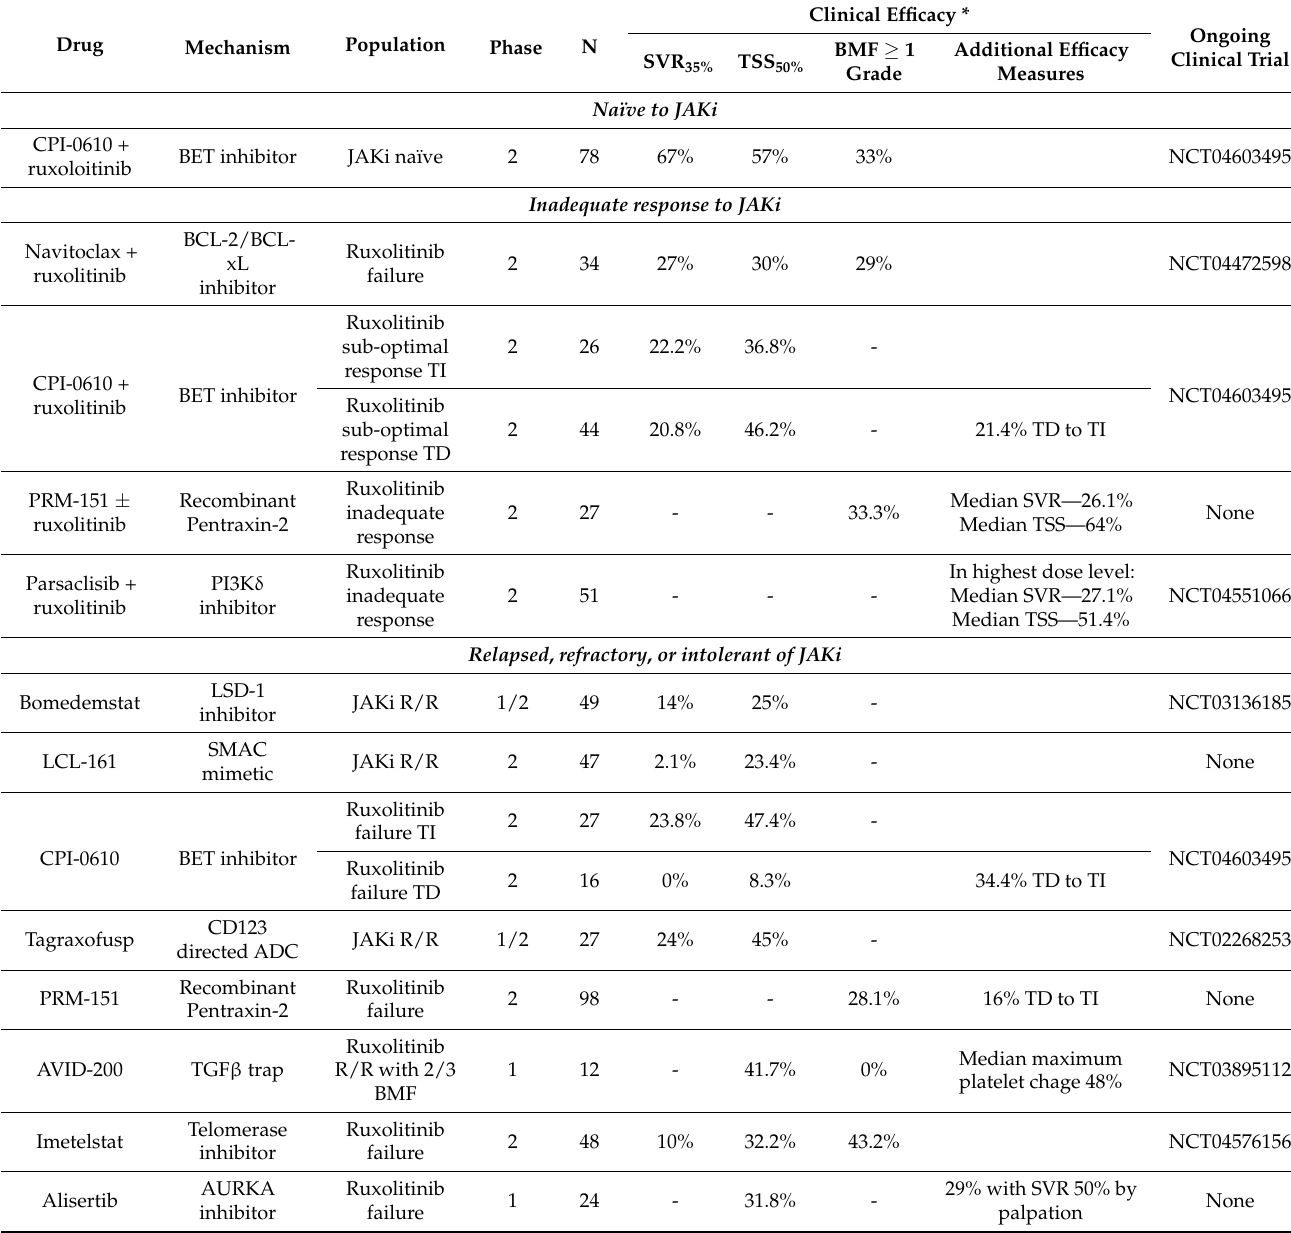
Table 1. Novel therapies in development for